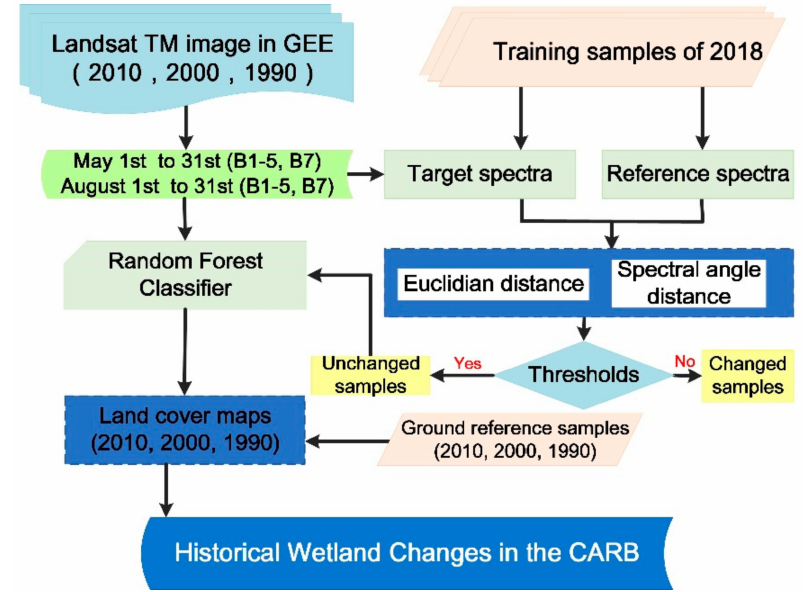
Figure 2. Workflow of land cover mapping of the CARB.